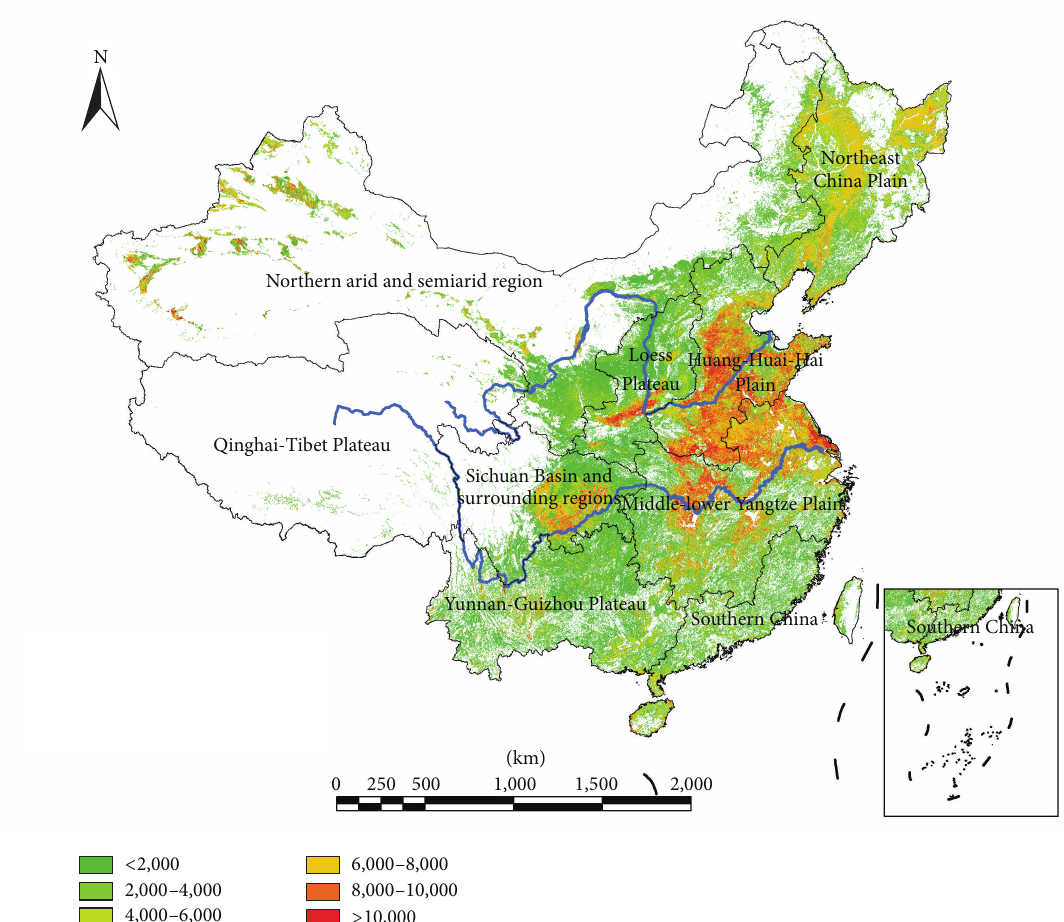
Figure 3: Distribution of production potential in China in 2010